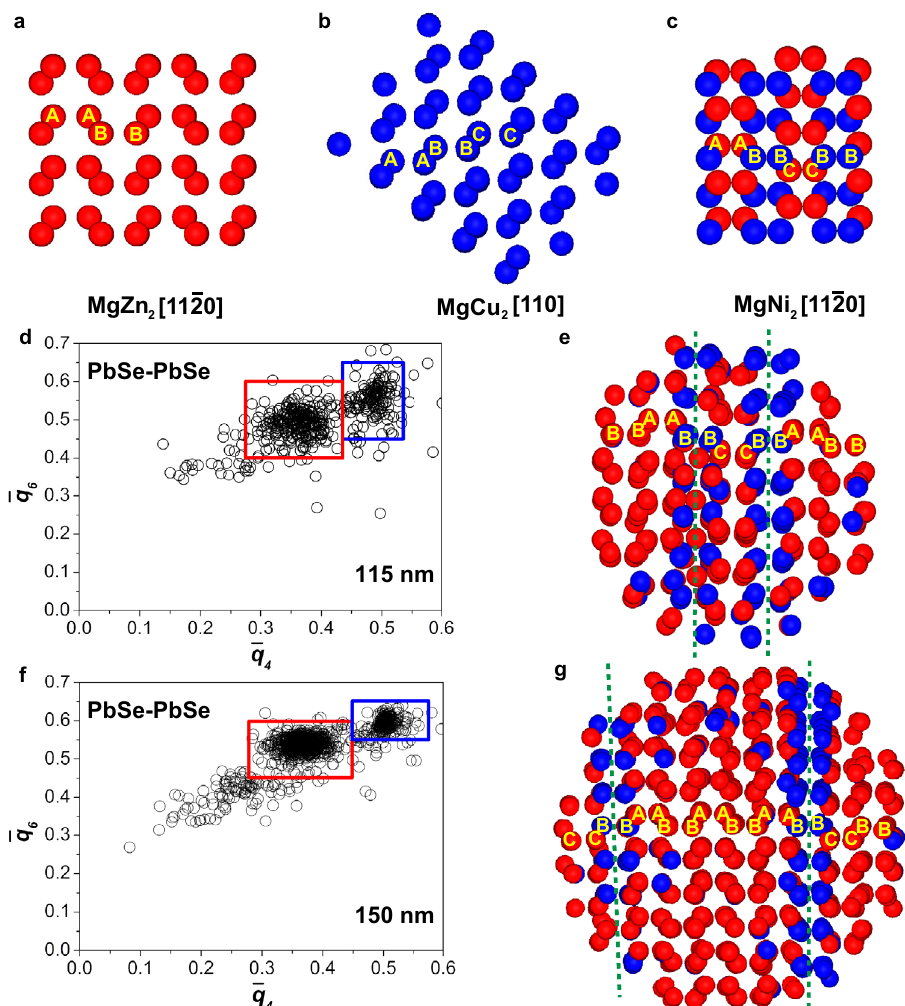
Fig. 4 BOP analysis of L species. Computer renderings of the L species (PbSe NCs) in the Laves phases ( a ) MgZn 2 , ( b ) MgCu 2 and ( c ) MgNi 2 , where the particles are colored according to their BOP values (see Supplementary Fig. 13). Scatter plots of the BOPs of the L species in the ( d ) 115 nm and ( f ) 150 nm- sized SPs, showing two distinct distributions corresponding to the hexagonal diamond (red) and cubic diamond (blue) symmetries. Computer renderings of the L species colored according to their BOP values within the red or blue rectangles in ( e ) 115 nm and ( g ) 150 nm-sized SPs, revealing the stacking faults (marked with green dashed lines) in the crystal. Interactive 3D views (( a ) – ( c ), ( e ) and ( g )) can be found in Supplementary Data 6 –